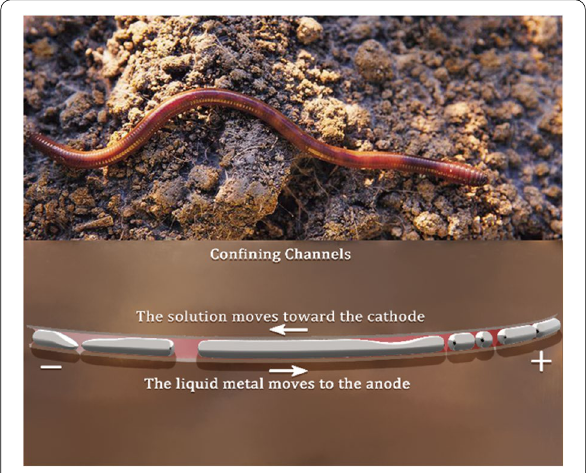
Figure 3 The electric actuation of liquid metal column, which like bionic earthworm